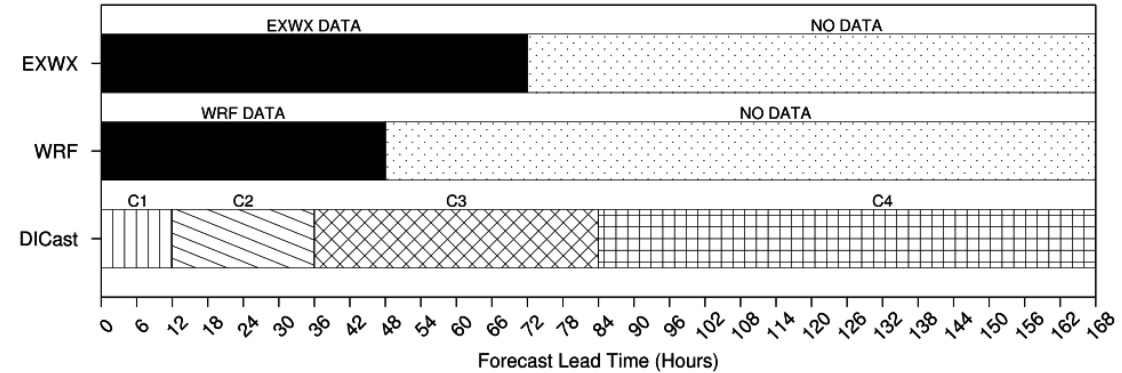
Figure 9. Summary schematic visualizing the various input datasets to the extreme weather system (ExWx). For DICast, C1-C4 indicate various configurations of the DICast forecast that are dependent on the input model data available at that lead time.